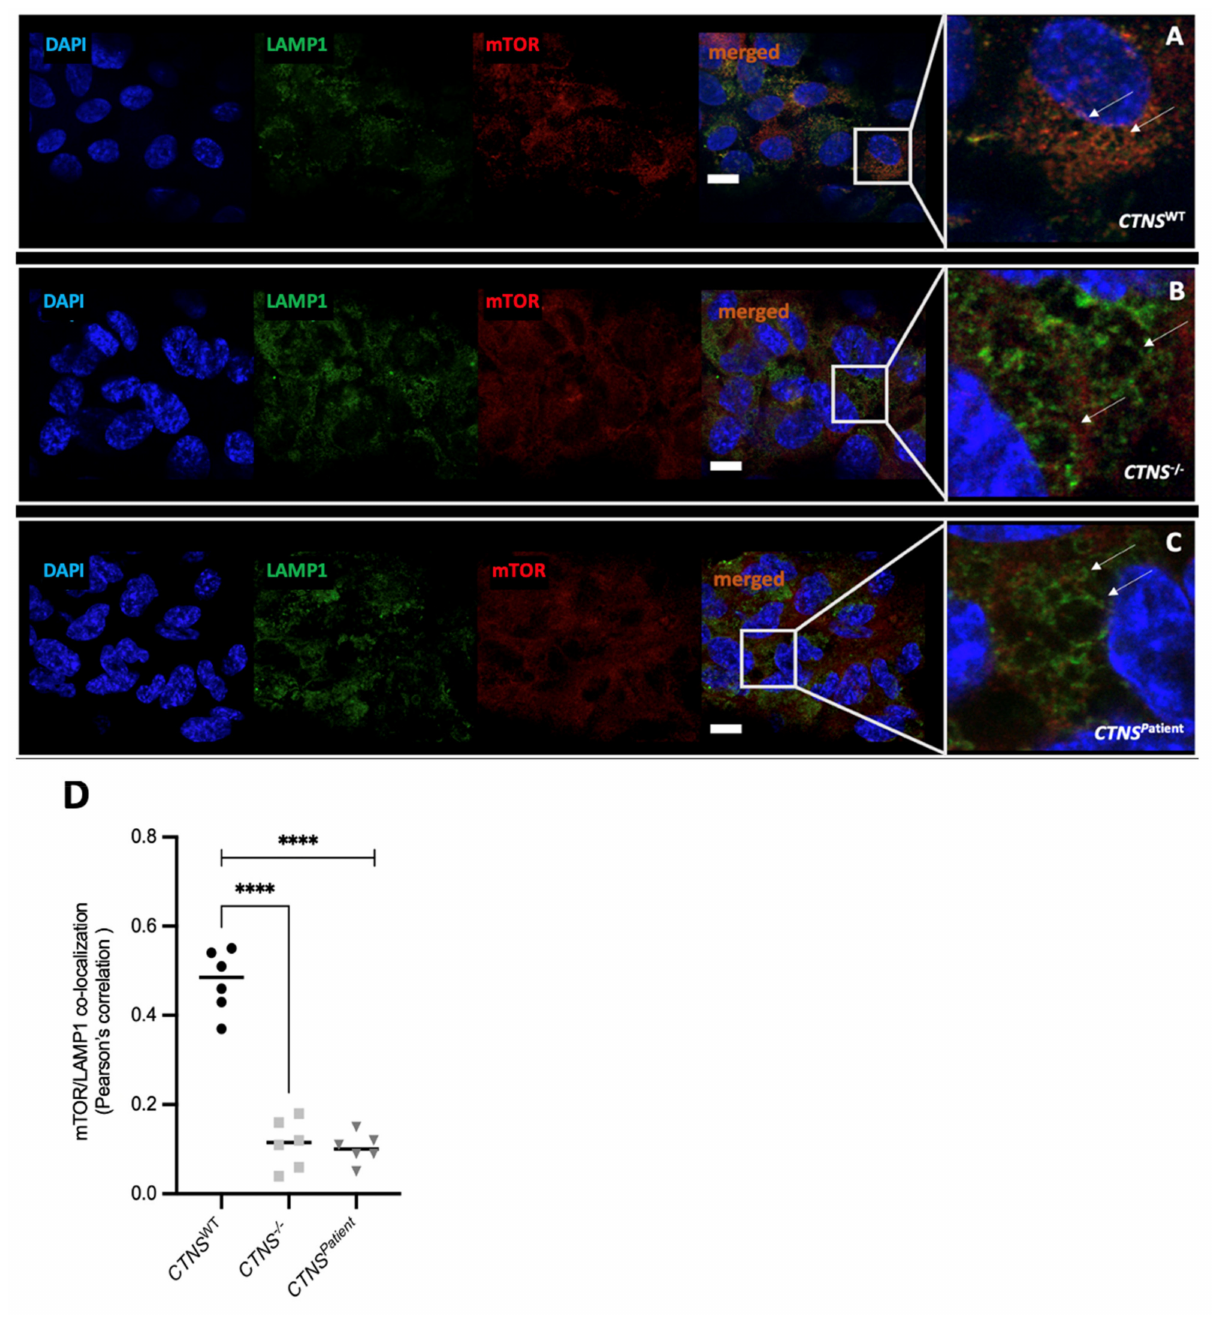
Figure 7. mTOR and LAMP1 staining and colocalization in kidney tubules. Confocal microscopy images taken at 63X of the ciPTEC CTNS WT ( A ), CTNS − / − ( B ), and CTNS Patient ( C ) kidney tubules. Im- age analysis quantification showed co-localization of the mTOR/LAMP1 complex in the healthy con- trol and loss of co-localization in both cystinotic models ( D ), suggesting an impaired autophagosome- lysosome trafficking. In blue: DAPI (nuclei), in green: LAMP1 protein, in red: mTOR protein. Scale bar: 10 µ m. One-way ANOVA statistical analysis was performed (N = 3; **** p -value <